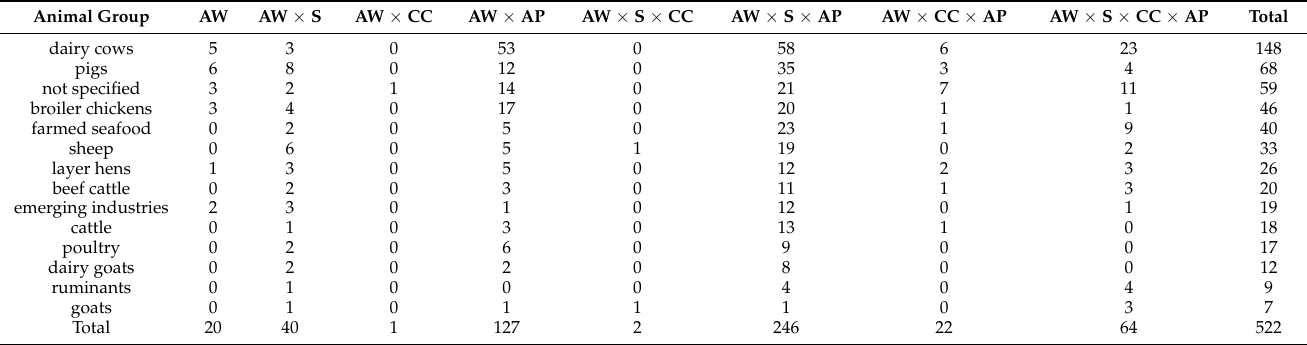
Table 3. Summary of articles discussing animal welfare (AW) interaction with Stress—S, Climate Change—CC, Animal Production—AP) in their research between 2015–2021.